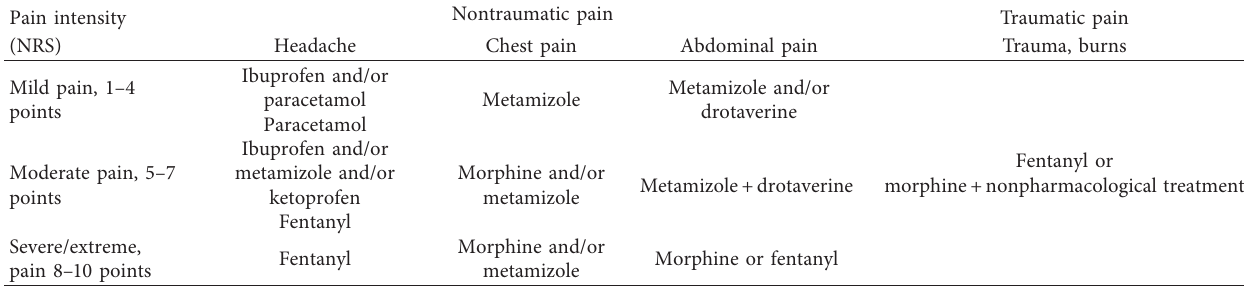
Table 1: The pain intensity, its etiology, location, and drugs recommended for the